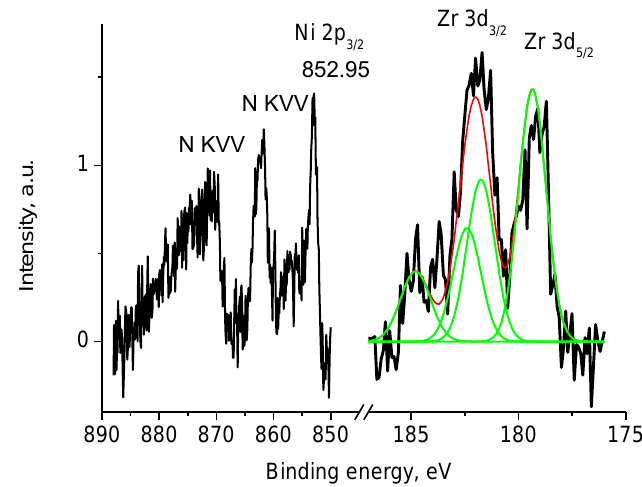
Figure 27. The Ni 2p and Zr 3d photoelectron spectra and N KVV Auger spectra of sample 2 (initial spectra – black, basic curves – green, resulting curve – red).